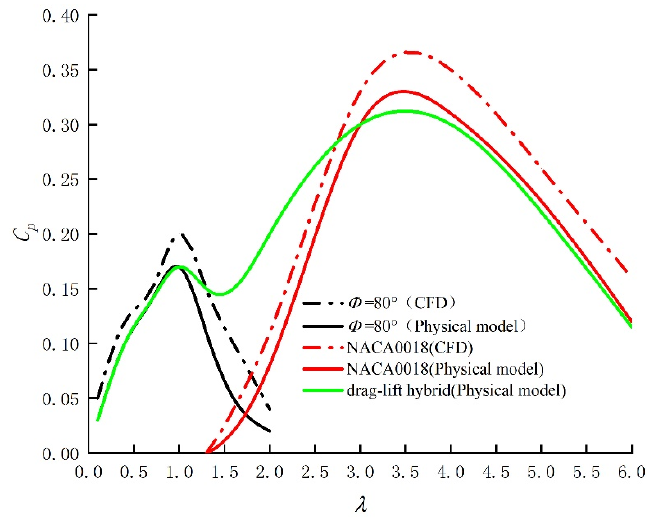
Figure 13. Curve of power coefficient with tip speed ratio.